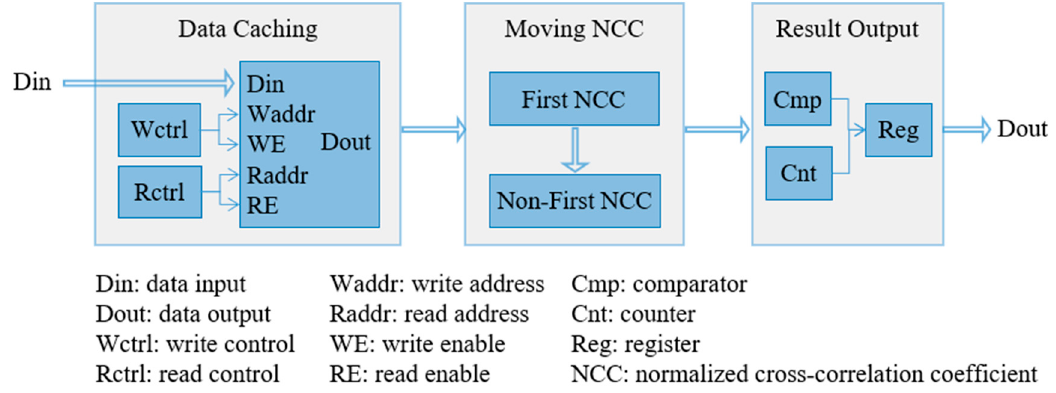
Figure 3. FPGA block diagram of the proposed frame synchronization method.